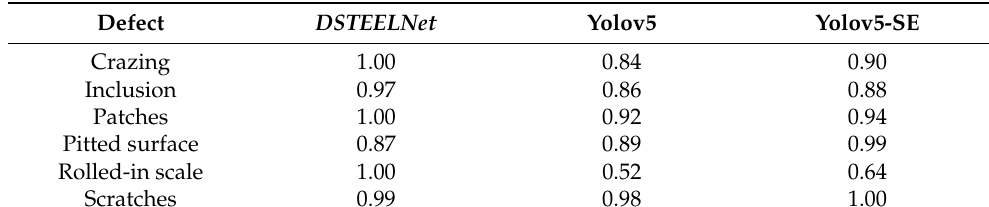
Table 4. Comparative results of single defect accuracy.